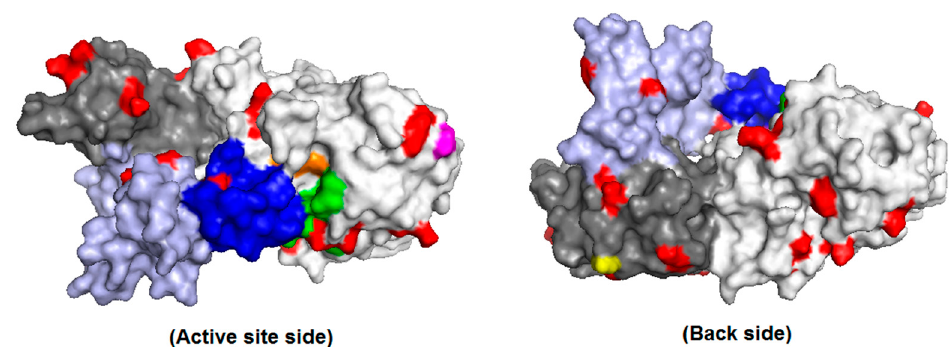
Figure 3. Three-dimensional structure of porcine pancreas lipase-colipase complex made with the program PyMol (The PyMol Molecular Graphics System; Version 2.1.0; Schrödinger, LLC). The complex (only chains A and B) is shown as surface mode from PDB structure (access code 1ETH). Chains A ( N -terminal domain in light gray and C -terminal domain in dark gray) and B (colipase in light blue) are shown, and amino acid residues are highlighted in red (Lys), orange (Ser 153 , Asp 177 , and His 264 catalytic triad), magenta ( N -terminal), yellow ( C -terminal), blue (lid–Cys 238 –Cys 262 segment), and green (loop—residues 77–88).